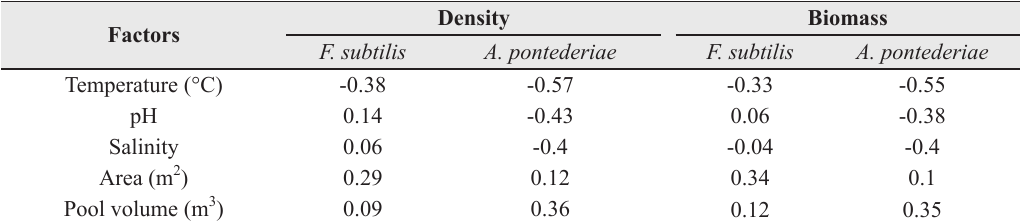
Spearman's correlation coefficient among abiotic factors (independent variables), density and biomass (dependent variables) of shrimp species from mangrove